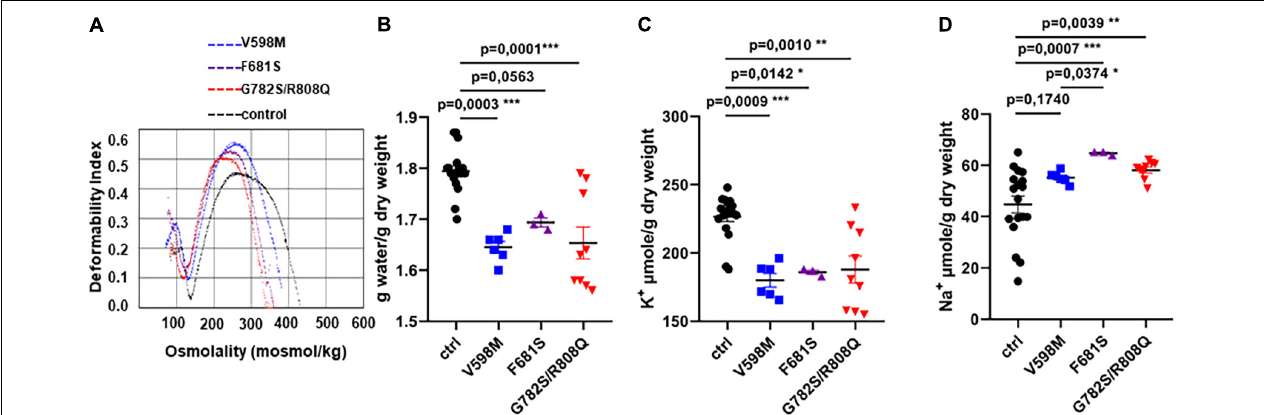
FIGURE 1 | (A) Ektacytometry profiles of RBC from three independent index-cases with clinical and biological phenotypes typical of hereditary xerocytosis, which were previously described. (B) water, (C) K + , and (D) Na + content of control or mutant RBC, measured in resting conditions 24 h after blood withdrawal. Statistical analyzes of the data were done with a Kruskal and Wallis test followed by a Dunn’s post-test. The p value is given on each figure. There were no significant differences ( p < 0.05) between mutants except the Na + content between V598M and F681S, p =